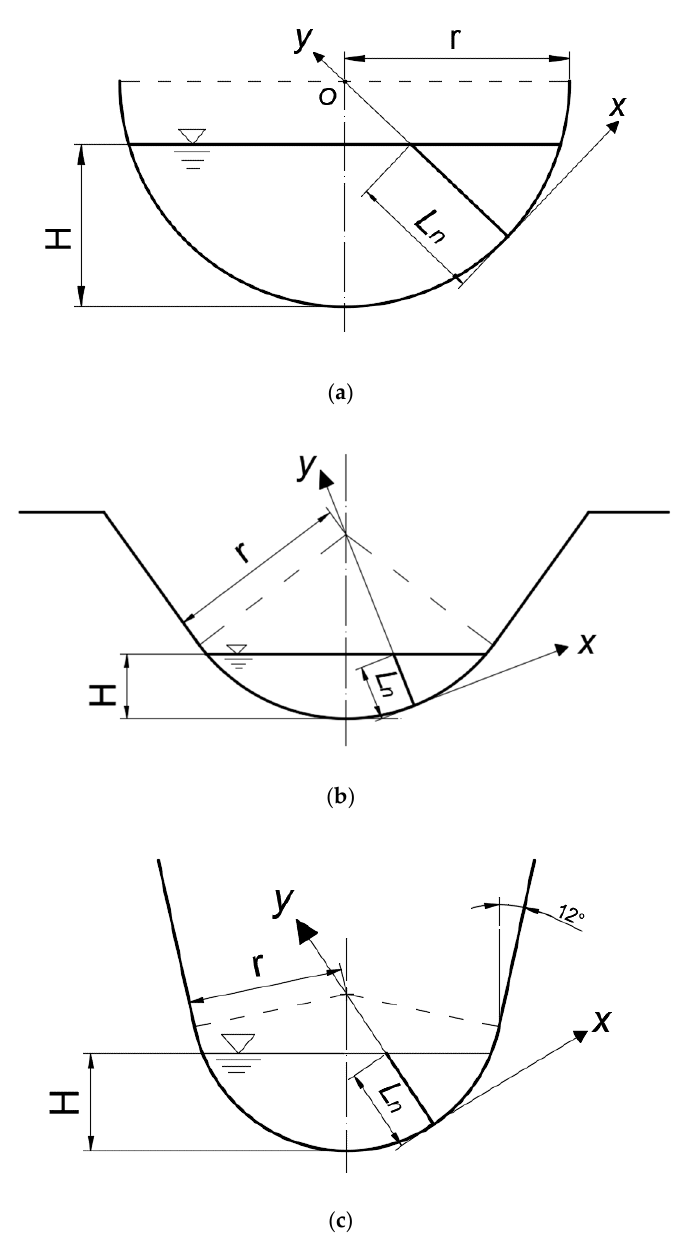
Figure 1. Three common kinds of cross-section types of channels with an arc-bottom. ( a ) Semicircle; ( b ) arc-bottom trapezium; ( c ) u-shaped. Here, x and y are the axes of the coordinate system, H is water depth, r is radius of the arc, and L n is the length of the underwater part of the line.